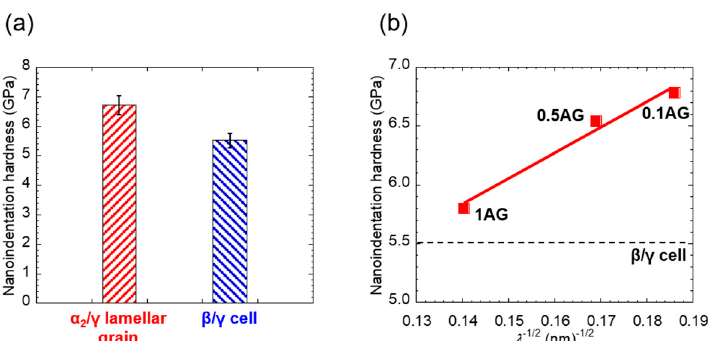
Figure 9. Nanoindentation hardness of the α 2 / γ lamellar grain and the β / γ cell in 0.1AG ( a ) and Hall–Petch plot of nanoindentation hardness of the α 2 / γ lamellar grains in the aged alloys as a function of reciprocal square root of λ ( b ).